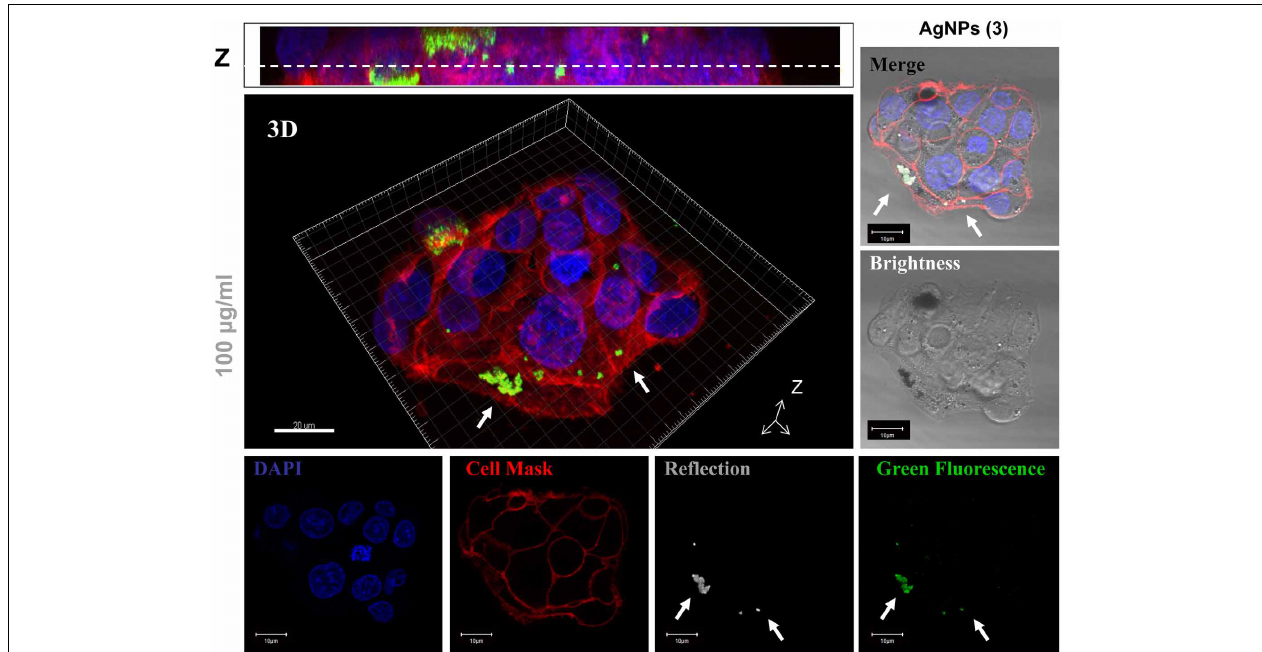
FIGURE 6 | Confocal Laser Scanning Microscopy (CLSM) in vivo images of internalized AgNPs (stabilized with compound 3) in HepG2 cells after 24h of treatment at 100 µ g/ml. Confocal images obtained of a single channels of nanoparticle fluorescence (green fluorescence), nanoparticle reflection brightness (gray), nuclear